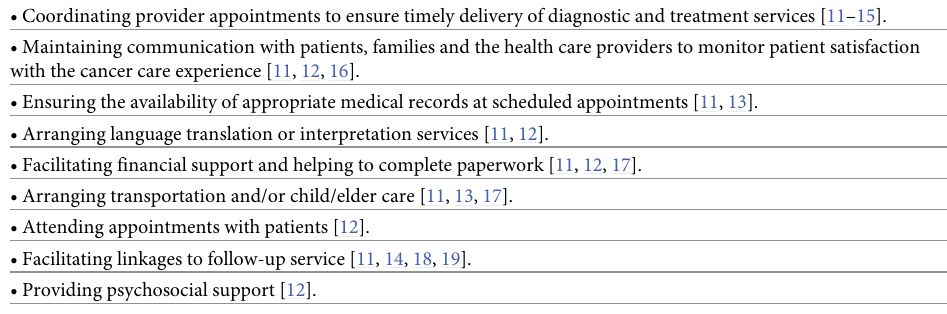
Table 1. Patient navigation services in high-income